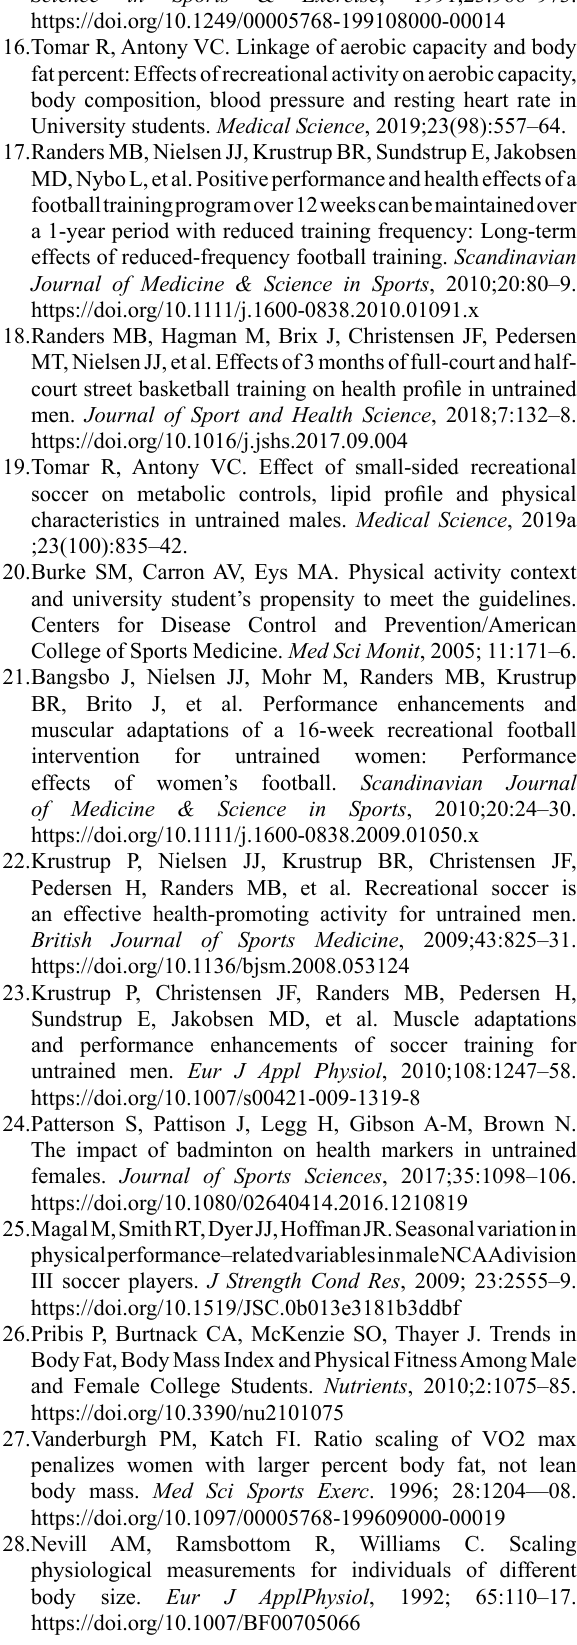
fat percent: Effects of recreational activity on aerobic capacity, body composition, blood pressure and resting heart rate in